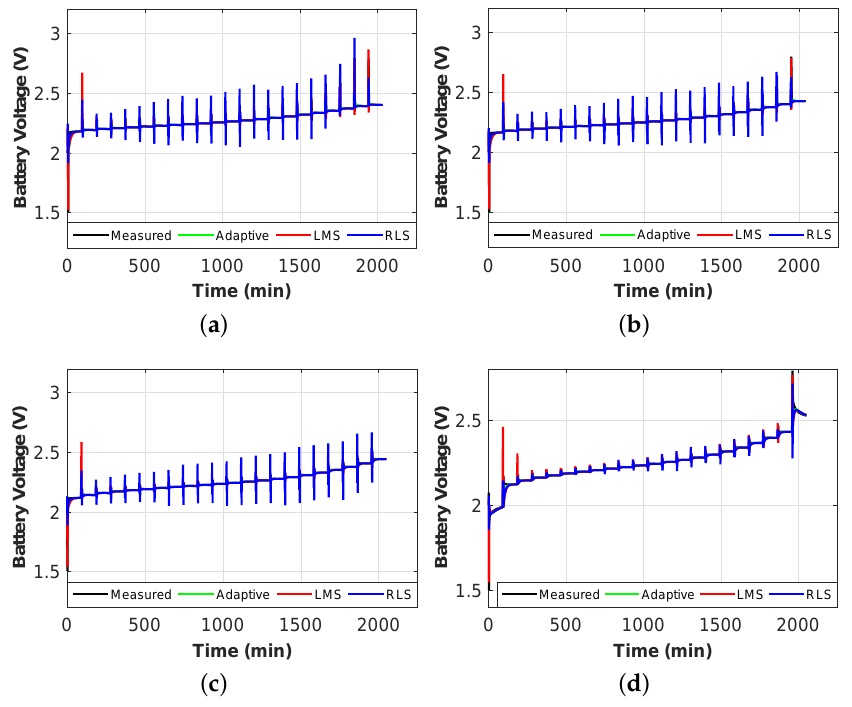
Figure 5. Battery’s voltage at different temperatures in charge mode. ( a ) 0 ◦ C; ( b ) 10 ◦ C; ( c ) 25 ◦ C; and ( d ) 40 ◦ C.